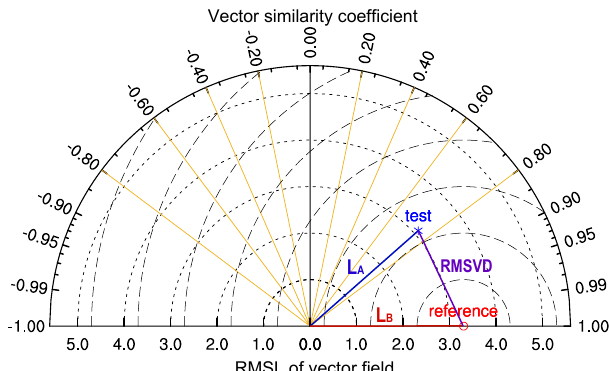
Figure 1. VFE diagram for displaying multiple statistics of two vec- tor fields. The vector similarity coefficient between two vector fields is given by the azimuthal position of the test field. The radial dis- tance from the origin is proportional to the RMSL of the vector field. L A and L B represent the RMSL of the test and reference vec- tor fields, respectively. The RMSVD between the test and reference fields is proportional to their distance (dashed contours are given in the same units as those for the